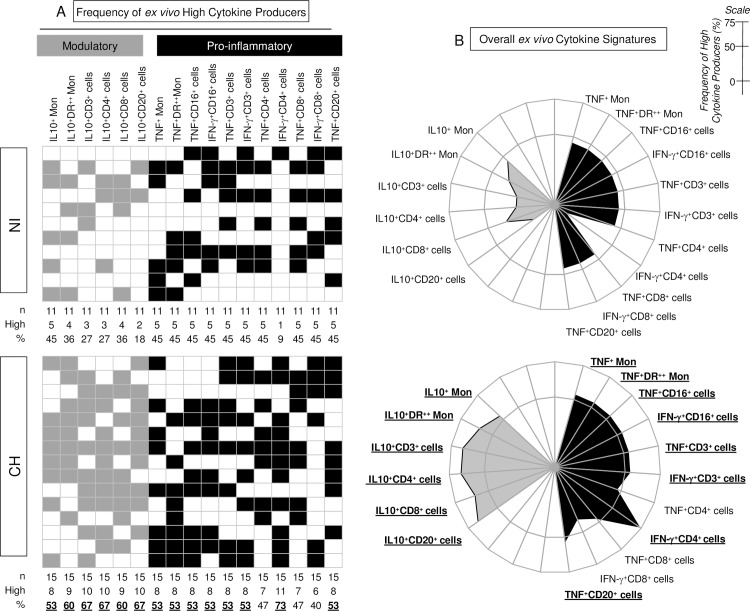
Ex vivo frequency of high cytokine producers and overall signatures in macaques naturally infected with TcI T. cruzi.(A) Gray-scale diagrams were used to compile the ex vivo frequency of high modulatory (gray square) and pro-inflammatory (black square) cytokine producers within T. cruzi-infected cynomolgus macaques (CH) and non-infected controls (NI). The global median values of cytokine+ cells were calculated, taken from the whole data universe (NI+CH, n = 26 non-human primates) and used as the cut-off mark to categorize each animal as “low” (white square) or “high” (gray square, black square) cytokine producers among NI and CH. Column statistics were run to quantify the frequency of high producers in each group. The biomarkers with frequencies above the 50th percentile are highlighted by bold underline format. (B) Radar charts summarizing the modulatory (gray area) and pro-inflammatory (black area) cytokine signatures in a range of leukocyte subsets (monocytes, NK-cells, T-cells and B-cells) were plotted to evaluate the proportion of high producers within a given cell subpopulation. The frequencies of high producers confined outside the inner circle (50th percentile) are underscored by bold underline format.